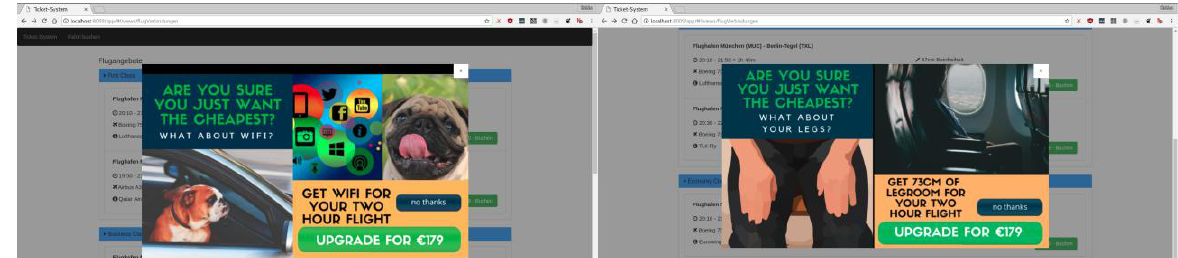
Figure 6. (a) Offering Wi-Fi upgrade for young passengers. (b) Offering more legroom for senior